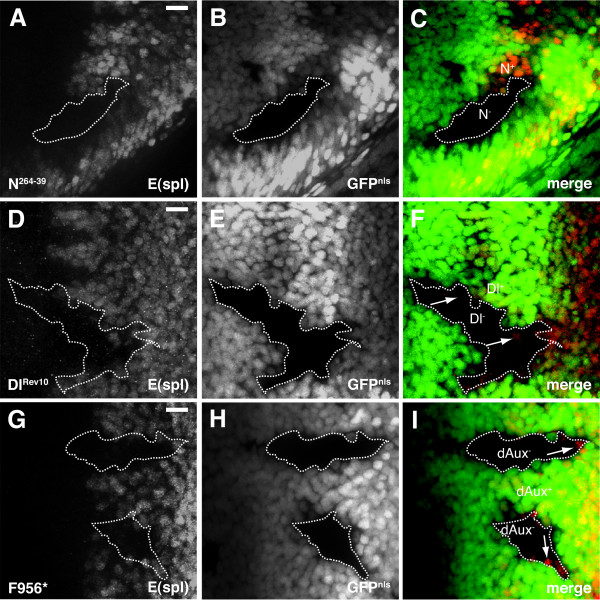
dAux functions in the signal-sending cells during Notch signaling. Projected spinning disk confocal images of (A-C) N264-39, FRT9-2/ubi-GFPnls, FRT9-2; Act5C>FLP/+, (D-F) ey-FLP/+; FRT82B, DlRevF10/FRT82B, ubi-GFPnls and (G-I) Act5C>FLP/+; FRT5-5Z3515, dAuxF956*/FRT5-5Z3515, ubi-GFPnls larval eye discs stained with mAB323 anti-E(spl) antibody (red). N264-39, DlRevF10 and dAuxF956* mutant cells are indicated by the absence of nuclear GFP, and the boundaries of mutant clones are outlined with dotted lines. Please note that all N264-39 cells are negative for E(spl) staining, whereas some DlRevF10 and dAuxF956* cells at the clone boundaries are E(spl)-positive (indicated by arrows). Scale bar, 10 μm.